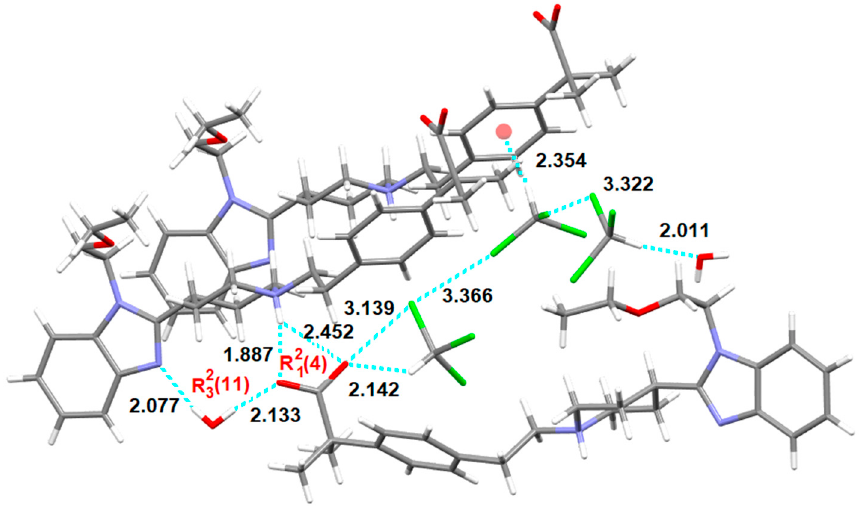
Figure 19. Intermolecular interactions (distances in Å) observed in the crystal structure of S 3CHCl3-H2O .